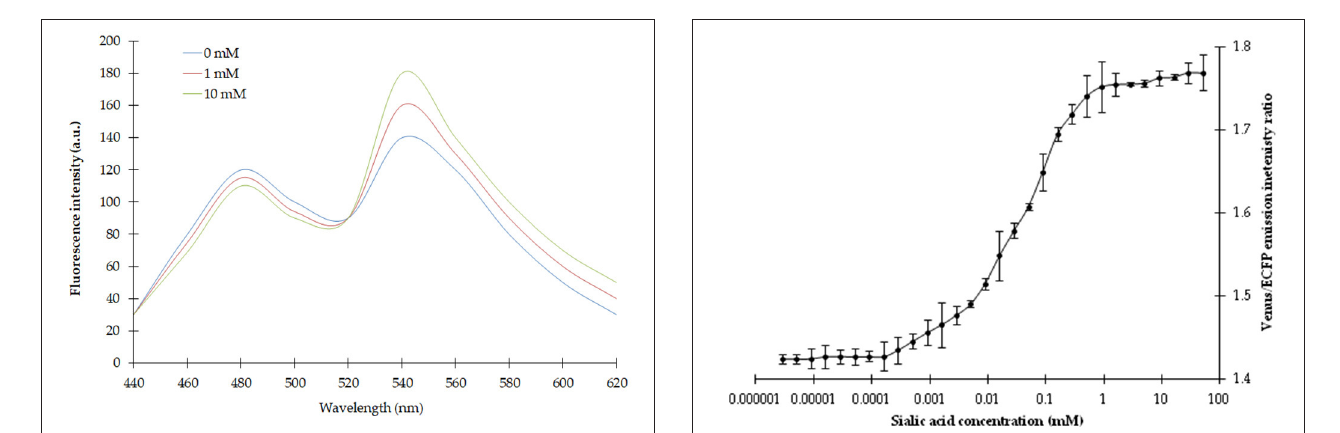
FIGURE 4 | Titration analysis of the nanosensor at different concentrations of NeuAc. The data are the average of three replications. Vertical bars show the standard errors. 0.20 mg/ml sensor protein was